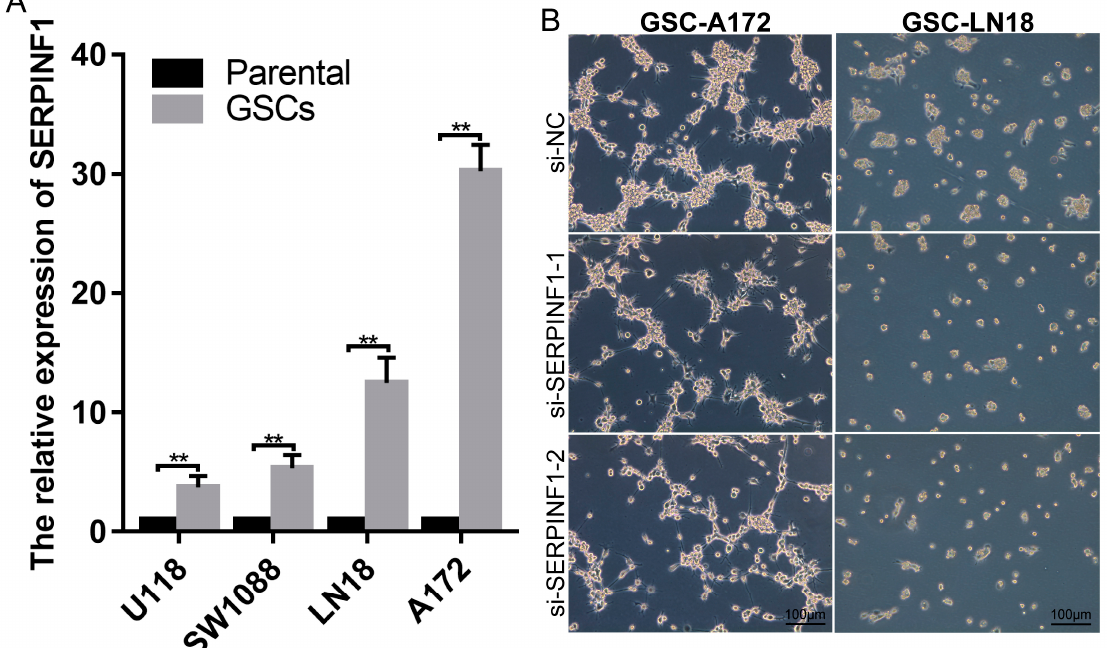
Figure 5. The role of SERPINF1 in GSCs. ( A ) Difference in SERPINF1 expression between GSCs and their parental cell lines. ( B ) The effect of SERPINF1 knockdown on the sphere formation of GSC- A172 and GSC-LN18. (** p < 0.01) .